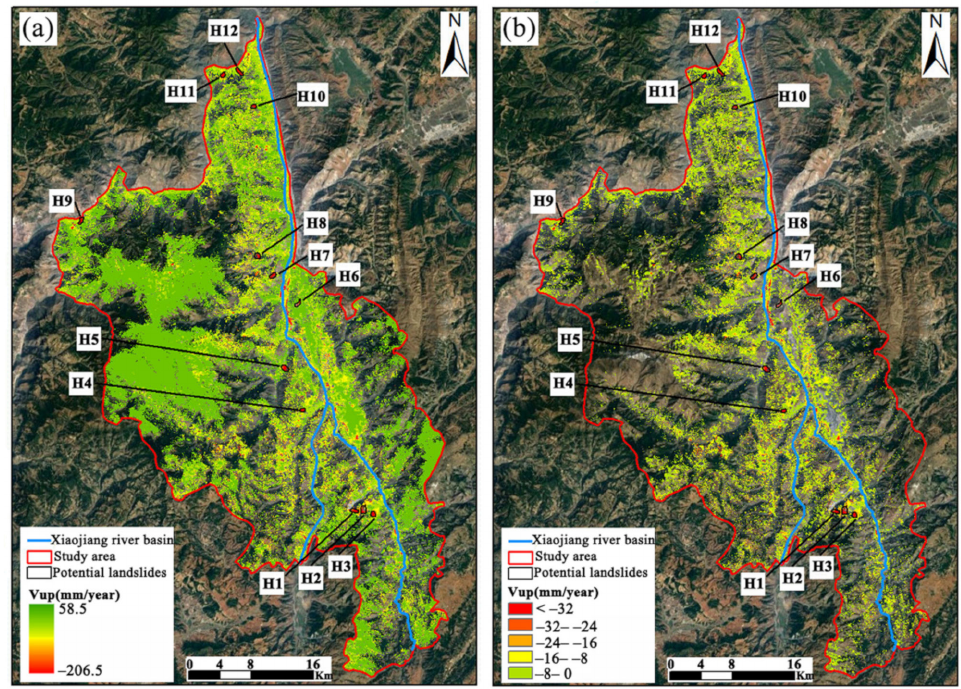
Figure 5. Vertical deformation rate results. ( a ) shows the results of the vertical deformation rate in the complete Dongchuan district, and ( b ) shows the results of the vertical deformation rate after excluding Vup > 0 and the flat